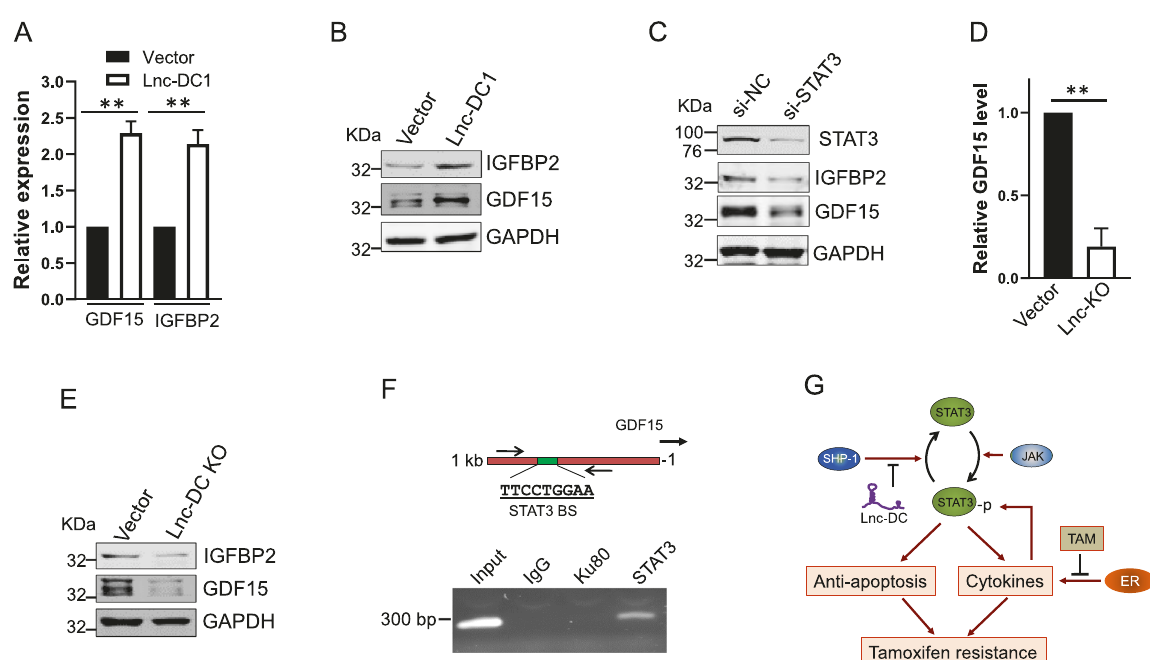
Fig. 6 Lnc-DC promotes expression of cytokine genes. A Lnc-DC1 upregulates GDF15 and IGFBP2 mRNA level, as detected by qRT-PCR. B Lnc-DC1 upregulates GDF15 and IGFBP2 protein level, as detected by western blot. C STAT3 siRNA reduces levels of cleaved PARP and Caspase 3 in Lnc-DC1 cells. D Lnc-DC KO causes downregulation of GDF15 as determined by qRT-PCR. E Lnc-DC KO reduces GDF15 and IGFBP2 protein level, as detected by western blot. F STAT3 binds to GDF15 promoter, as detected by ChIP assay. Up panel, schematic description of GDF15 promoter carrying a putative STAT3 binding site. G Possible role of Lnc-DC in regulation of STAT3-cytokine loop, leading to tamoxifen resistance. Values are mean ± SD ( n = 3). ** p <